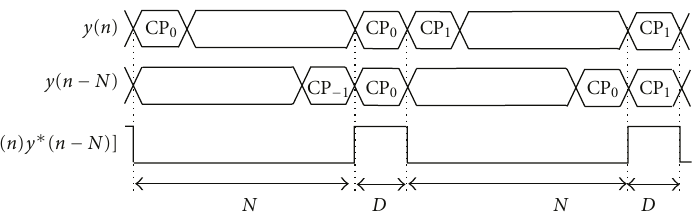
Figure 1: Ideal autocorrelation signal of an OFDM symbol burst.